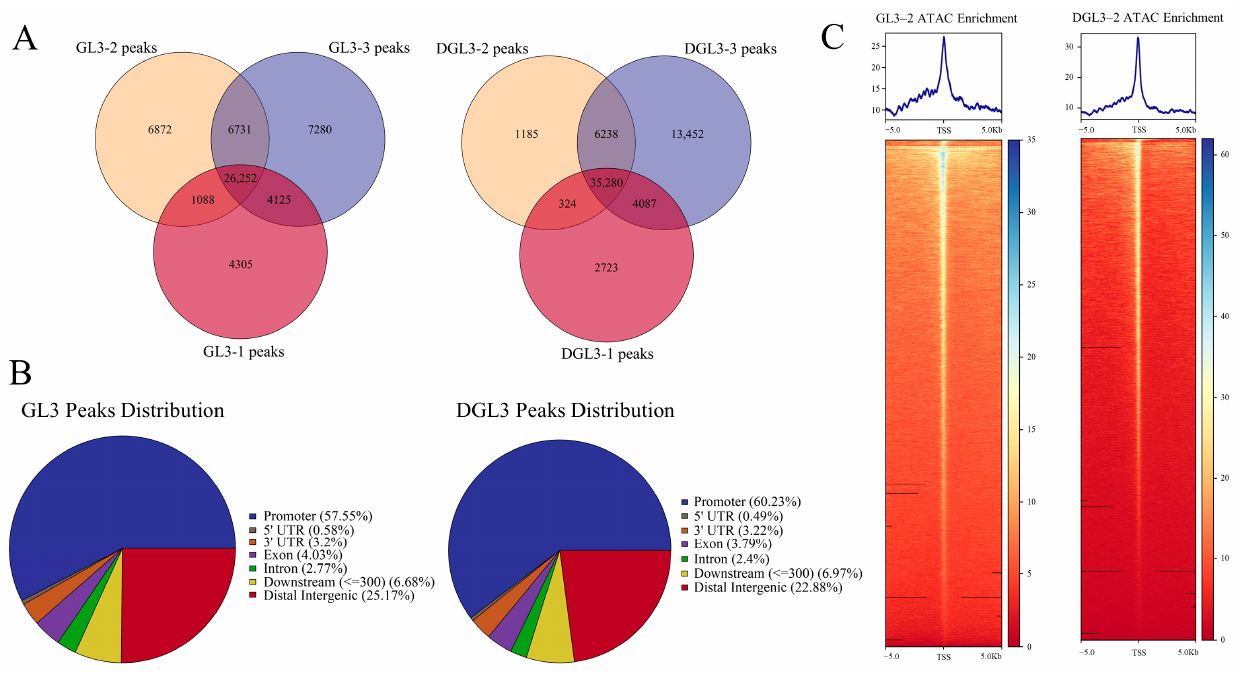
Figure 2. Characterization of ATAC signals after drought treatment of GL3 and DGL3. Different colors of the Venn plot represent different biological replications. ( A ) The Venn plots of three biological replicates of normal and drought treatment. ( B ) The distribution of the overlapping ATAC signals. ( C ) Distribution of partial samples of ATAC signals in the TSS region. Bin = 1.